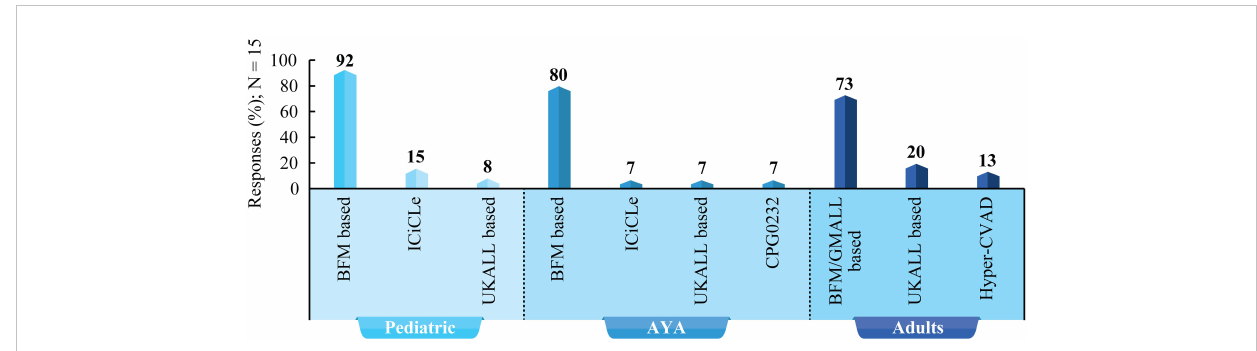
FIGURE 3 Treatment protocols for children, AYA, and adults with B-ALL: Survey results based on experts ’ clinical practice. BFM, Berlin – Frankfurt – Munster; CVAD, Cyclophosphamide, vincristine sulfate, doxorubicin hydrochloride (Adriamycin), and dexamethasone; UKALL, United Kingdom Acute Lymphoblastic Leukemia; GMALL, German Multicenter Study Group for Adult Acute Lymphoblastic Leukemia; ICiCLe, The Indian Childhood Collaborative Leukemia; AYA, Adolescents and young